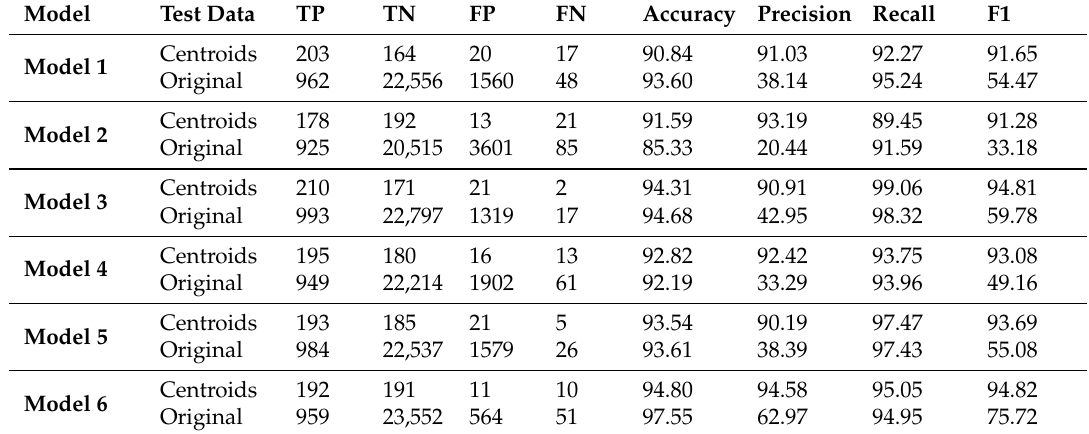
Table 4. Performance evaluation of the ANN models on test